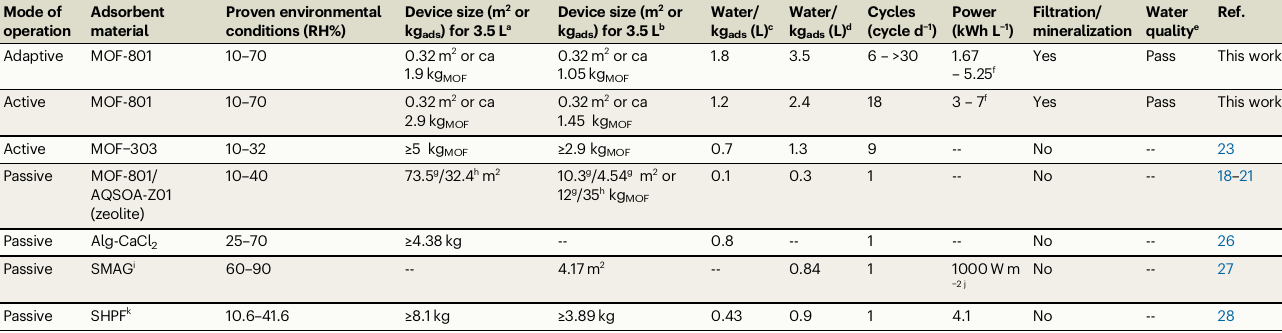
Table 1 | Performance comparison of reported adsorbent-based water harvesters with different modes of operation Mode of Adsorbent Proven environmental Device size(m 2 or operation material conditions(RH%) kg ads ) for 3.5L a